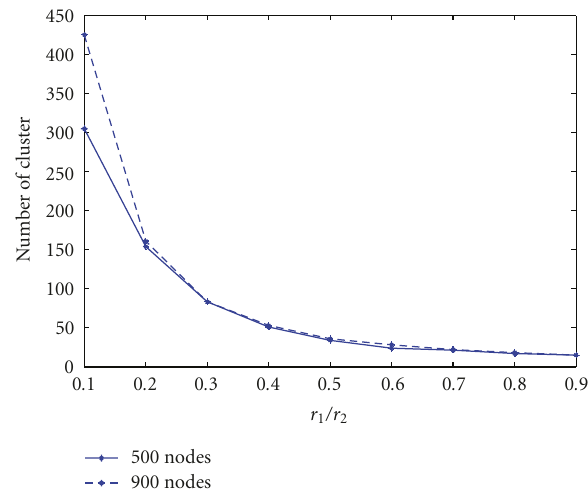
Figure 5: Relation between r 1 /r 2 and number of cluster